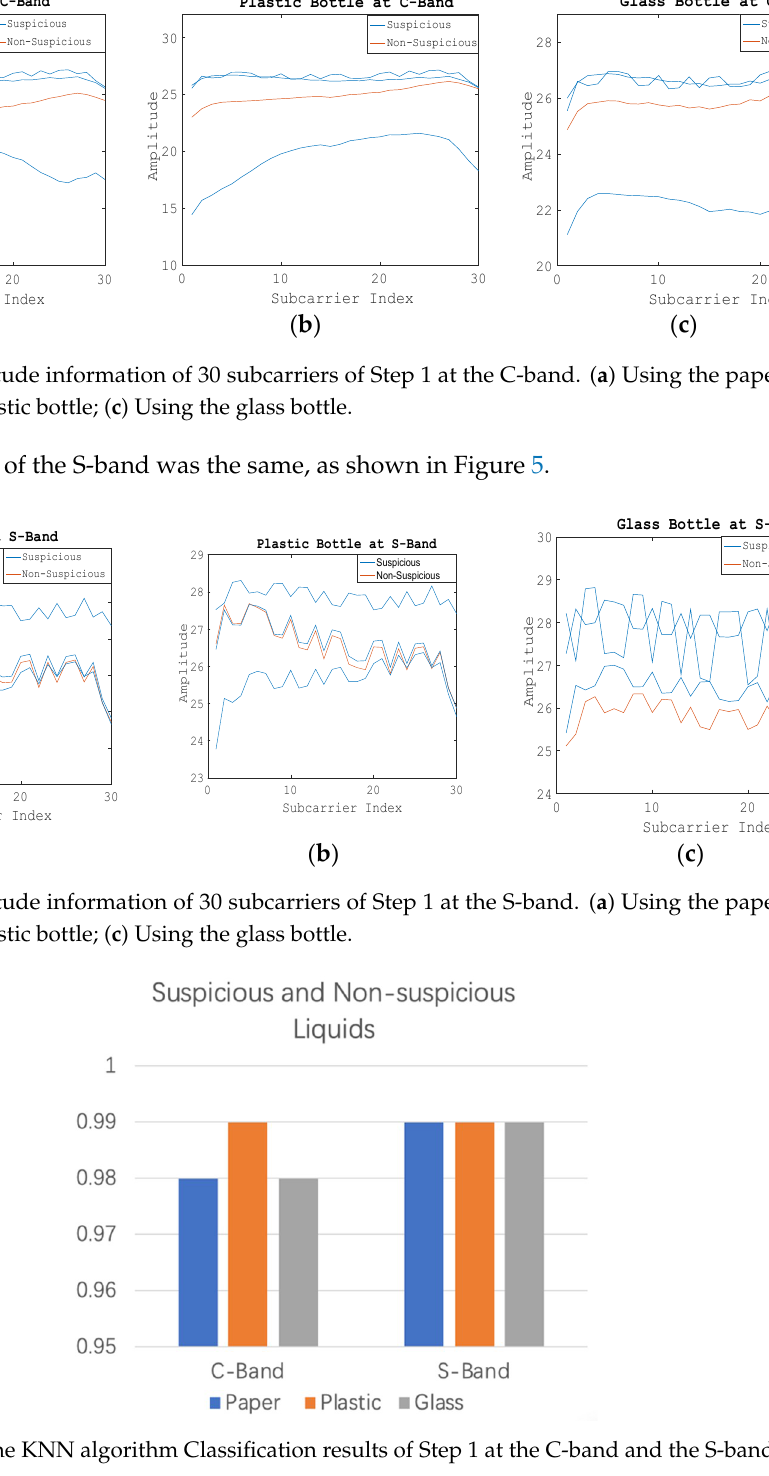
Figure 6. The KNN algorithm Classification results of Step 1 at the C-band and the S-band.